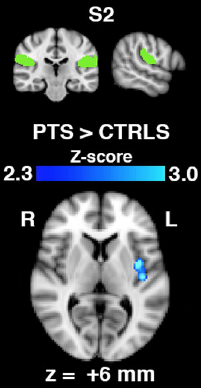
Figure 2. Brain regions (bottom, in blue-to-light blue) exhibiting greater connectivity with the secondary somatosensory cortex (S2) seed region (top, in green) in hip OA patients (n = 30) than in control subjects (n = 10), expressed as a statistical Z-score of the difference. Regions include only the left posterior insula (z-coordinate of shown brain slice corresponding to the MNI brain template.